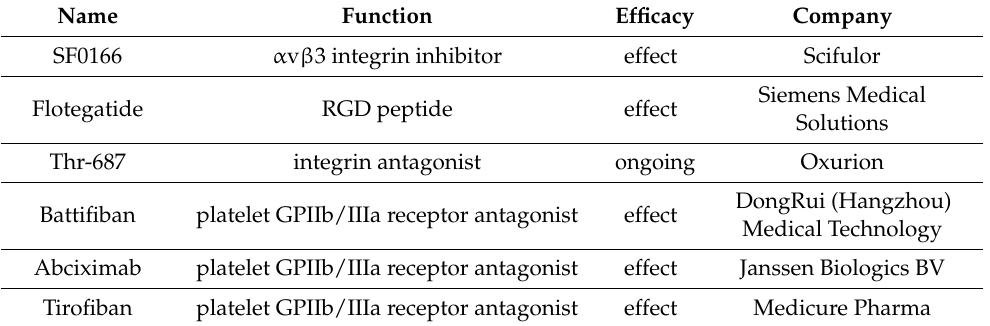
Table 2. Current targeted drugs for VTN and its